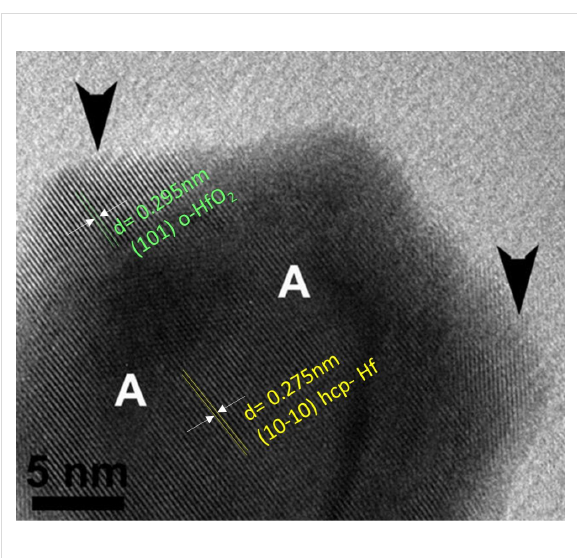
Figure 2: HRTEM image of a Hf nanoparticle showing a distinct core–shell structure: In the core area lattice fringes of d = 0.275 nm corresponding to (10 − 10) Hf can be seen marked as A. The shell is composed of orthorhombic HfO 2 nanocrystallites indicated by arrows exhibiting lattice fringes of d = 0.295 nm corresponding to (101) HfO 2 embedded in an amorphous layer.